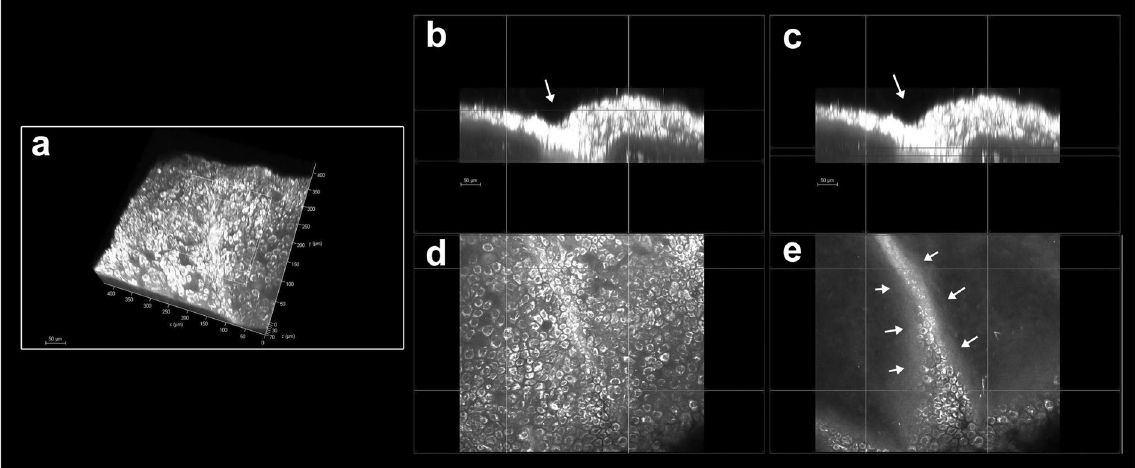
Figure 1. Pseudo-palisade of Vogt in the hemicornea . ( a ) Three-dimensional (3D) reconstruction of the hemicornea (TPEF signal) showing the pseudo-palisade of Vogt (scale bar 50 µ m). Cross-sections ( b and c ; 400 × 60 µ m) and enface ( d and e ; 400 × 400 µ m) images of the hemicornea at different depths highlighting the intrastromal digital invasion by basal epithelial cells (arrows). This structure was randomly observed in scattered regions the hemicornea . The palisades of Vogt are distinctive features of the adult corneoscleral limbus and represent the specialized microenvironment (niche) of corneal stem cells.